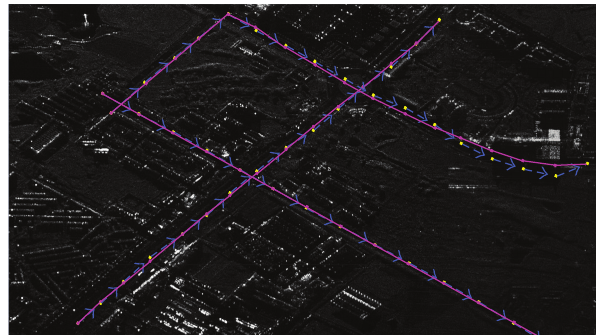
Figure 9: Road center-points extraction methods comparison 2.